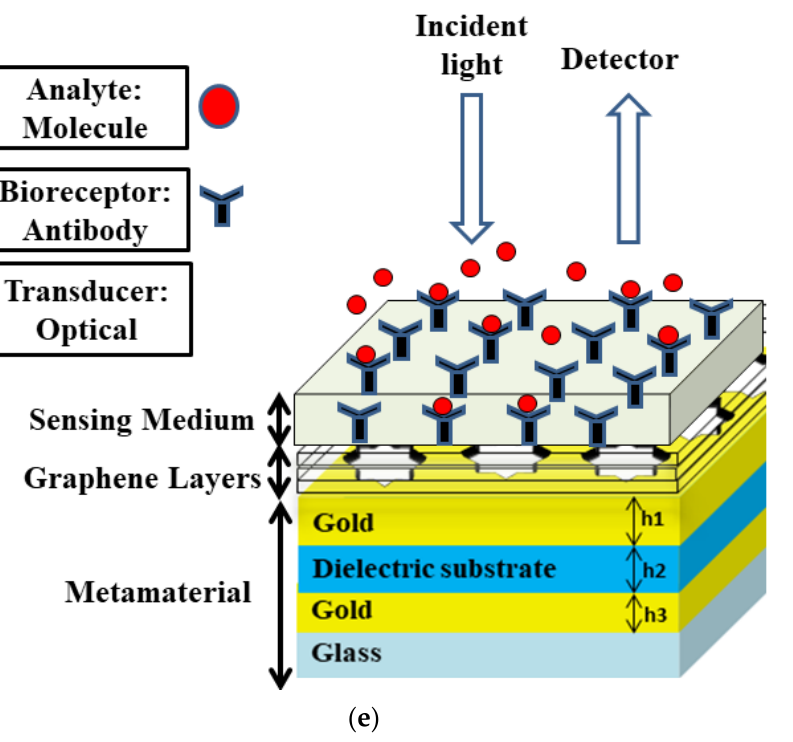
Figure 1. Geometry and method of the proposed graphene-based plasmonic metamaterial perfect absorber; ( a ) perspective view; ( b ) top view of the 2-dimensional OSS holes embedded in a gold film; ( c ) simulation setup of a unit cell; ( d ) proposed fabrication steps for the realization; ( e ) proposed biosensor showing sensing surface, receptors, and biomarkers.